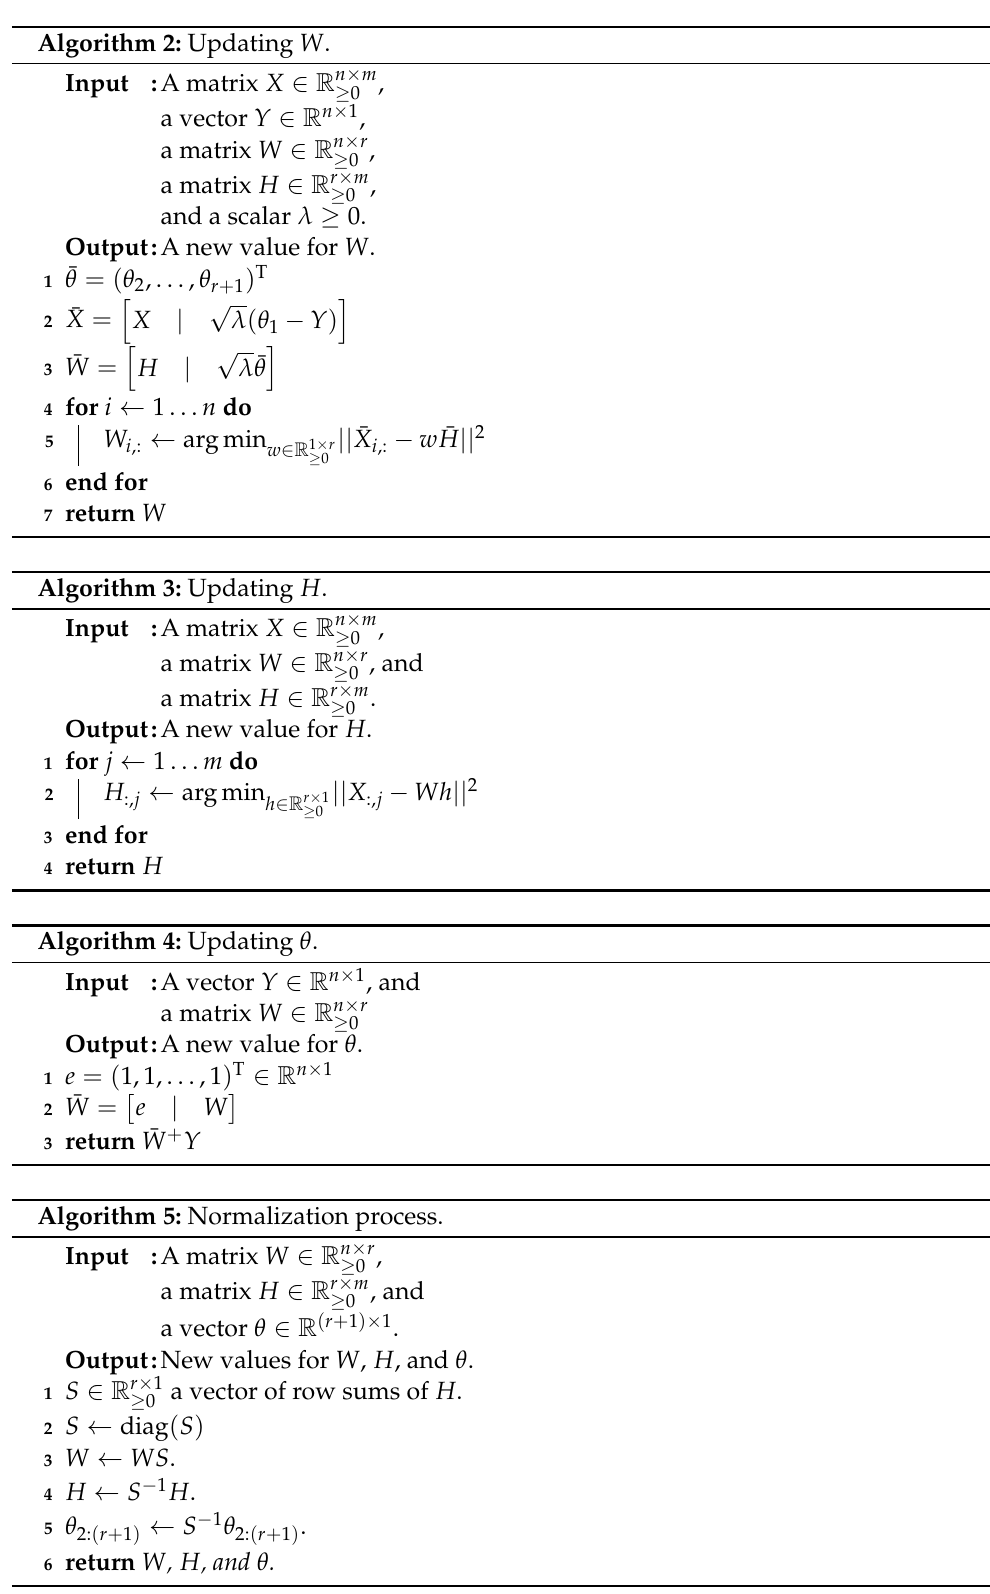
Algorithm 5: Normalization